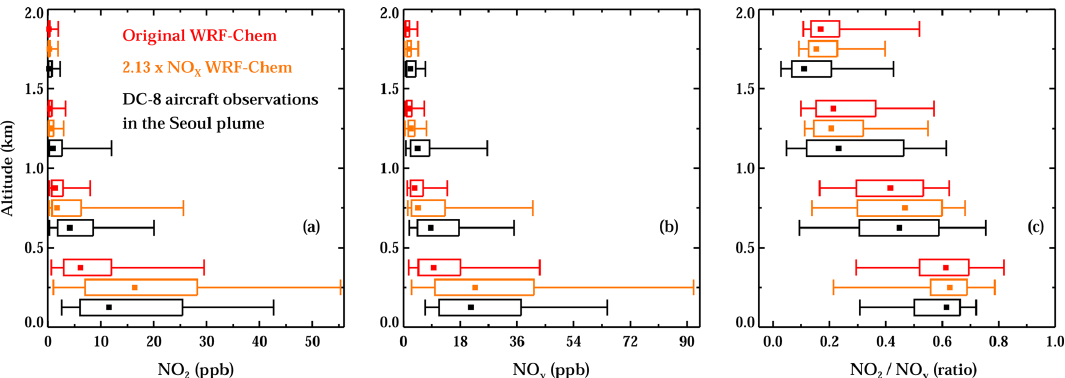
Figure 9. Measurements from the DC-8 aircraft binned by altitude in black. Co-located WRF-Chem within the same altitude bin as the aircraft observations are plotted above in red for the original and in orange for the 2 . 13 × NO x emissions simulation. Square dots represent the median values. Boxes represent the 25th and 75th percentiles, while whiskers represent the 5th and 95th percentiles. (a) Comparison of NO 2 in the Seoul plume (SW corner: 37.1 ◦ N, 127.05 ◦ E; NE corner: 37.75 ◦ N, 127.85 ◦ E), (b) comparison of NO y in the Seoul plume,